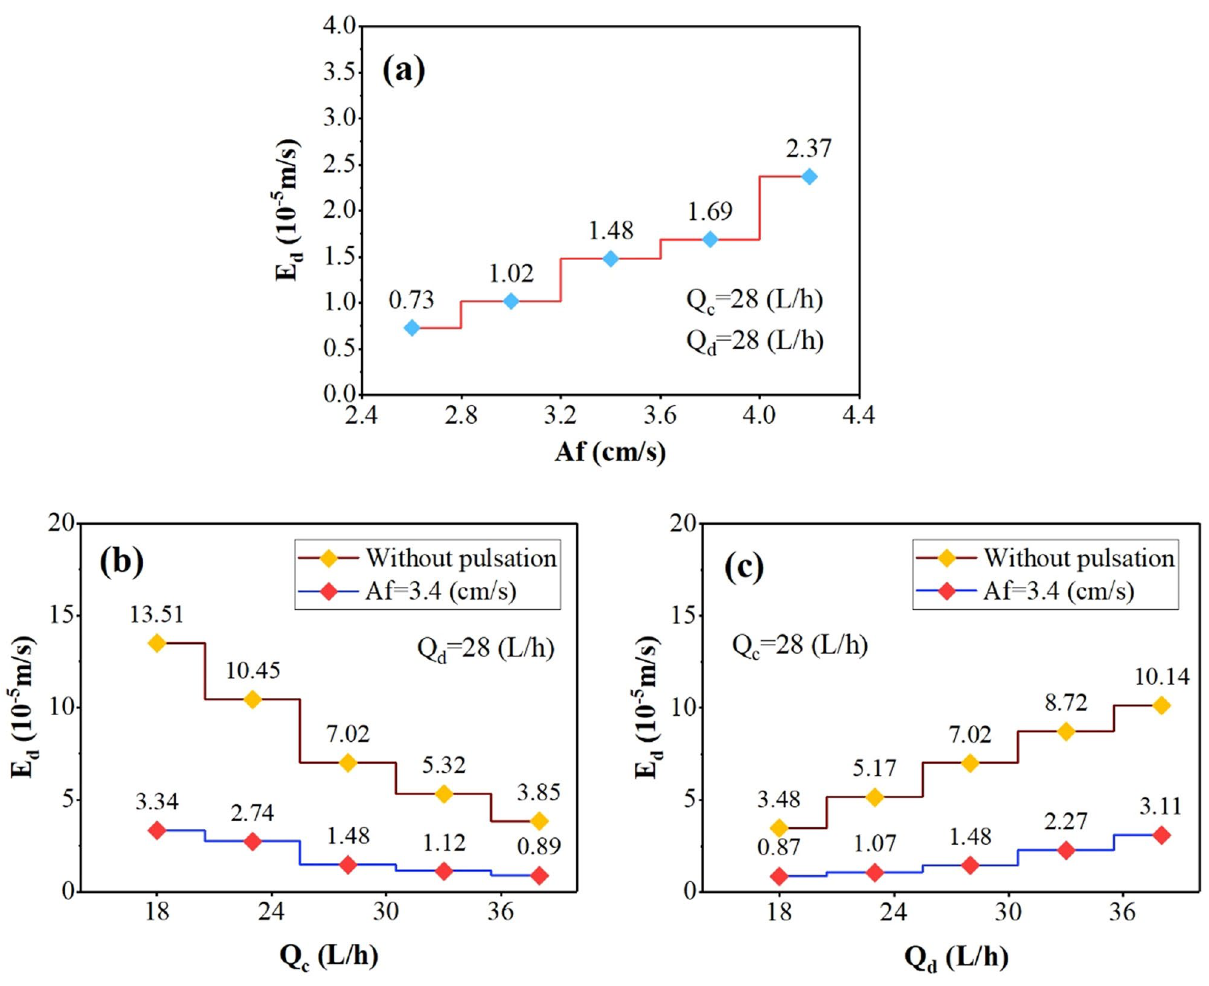
Figure 10. The effect of operating parameters [( a ) pulsation intensity, ( b ) aqueous phase flow rate, and ( c ) organic phase flow rate] on the dispersed phase axial dispersion